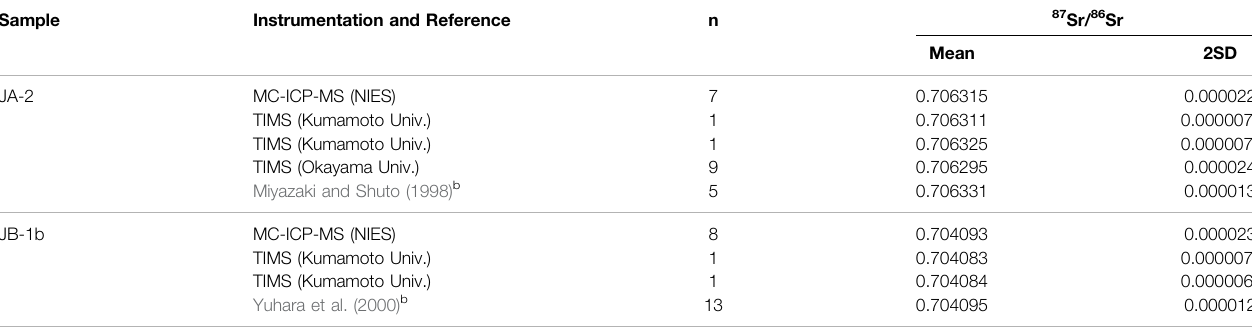
TABLE 2 | Sr isotopic compositions of JA-2 and JB-1b.